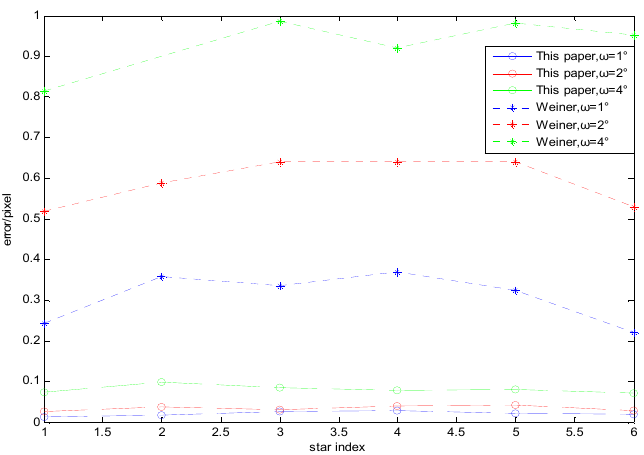
Figure 15. Errors of the star centroid coordinates for each method under different dynamic conditions.